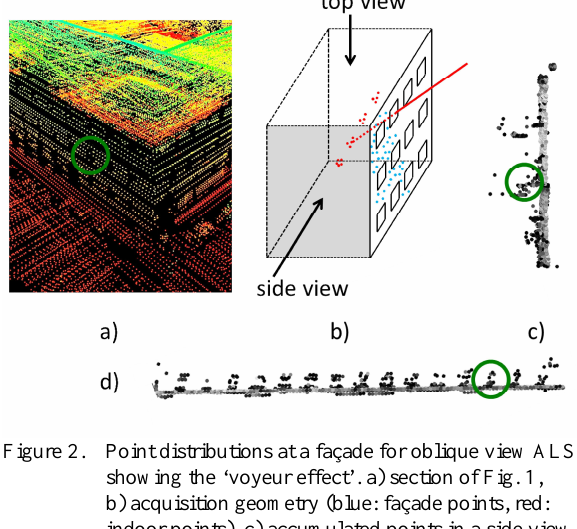
Figure 2. Point distributions at a façade for oblique view ALS